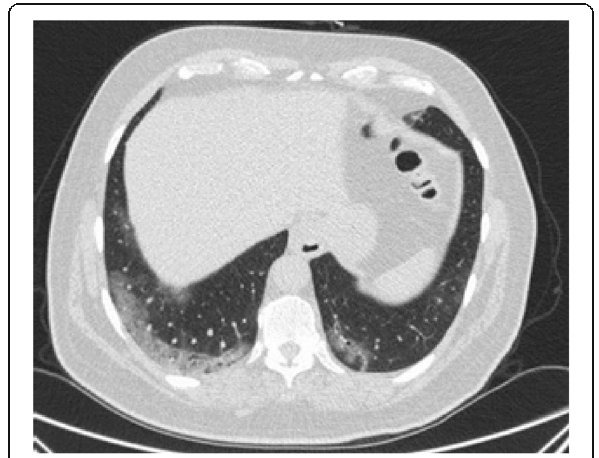
Fig. 2 COVID-19 pneumonia: thin section CT shows bilateral subpleural GGO and septal thickening